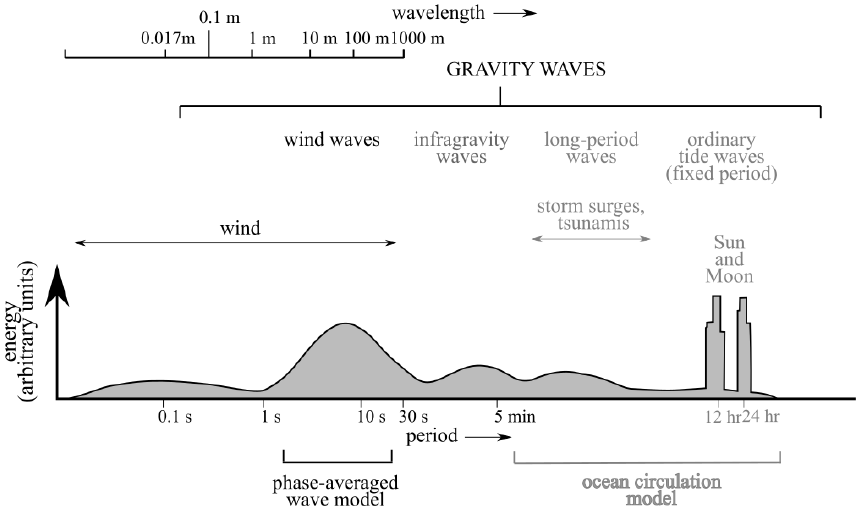
Figure 1. Energy spectrum for wave frequencies in the ocean showing the role of phase-averaged spectral wave models. Adapted from Wright et al.